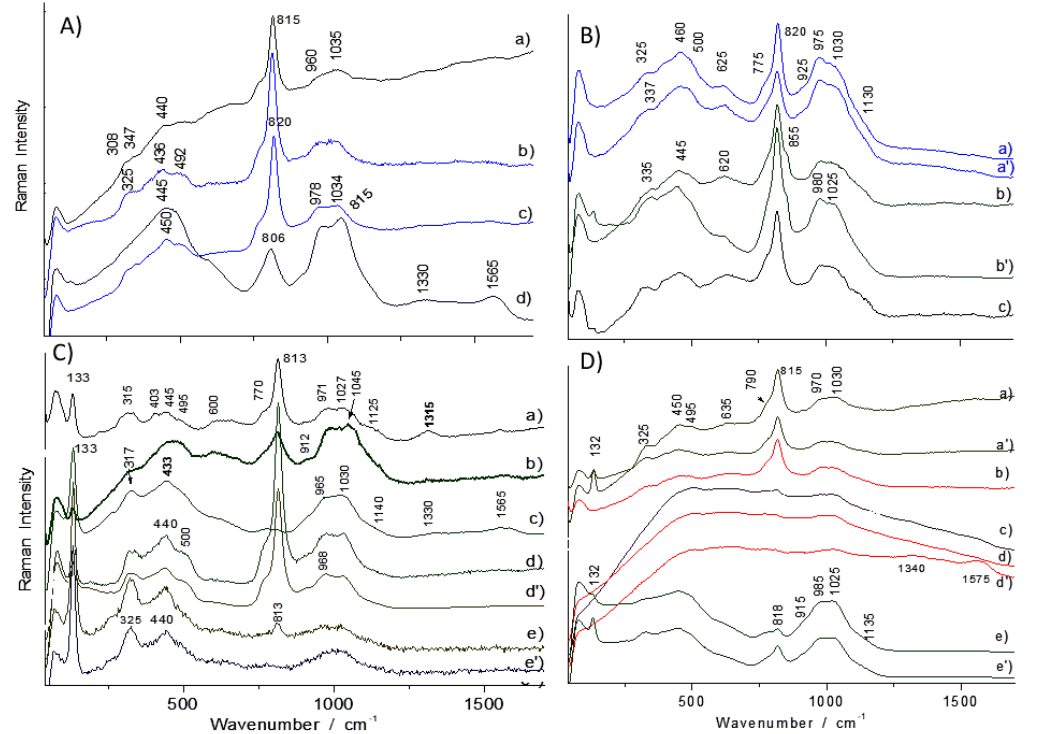
Figure 9. Representative Raman spectra recorded on R957 (left, A , C , mid 18th c.) and R958 (right, B , D , 2nd half of 18th c) dishes: ( A , B ) white (a,a′) and blue (b,c,b′) and dark blue (d) areas; ( C , D ) yellow and green areas (see text); R958: spectra c, d and d’ for red areas included. Noisy spectra are obtained with very short recording time to prevent any change due to local